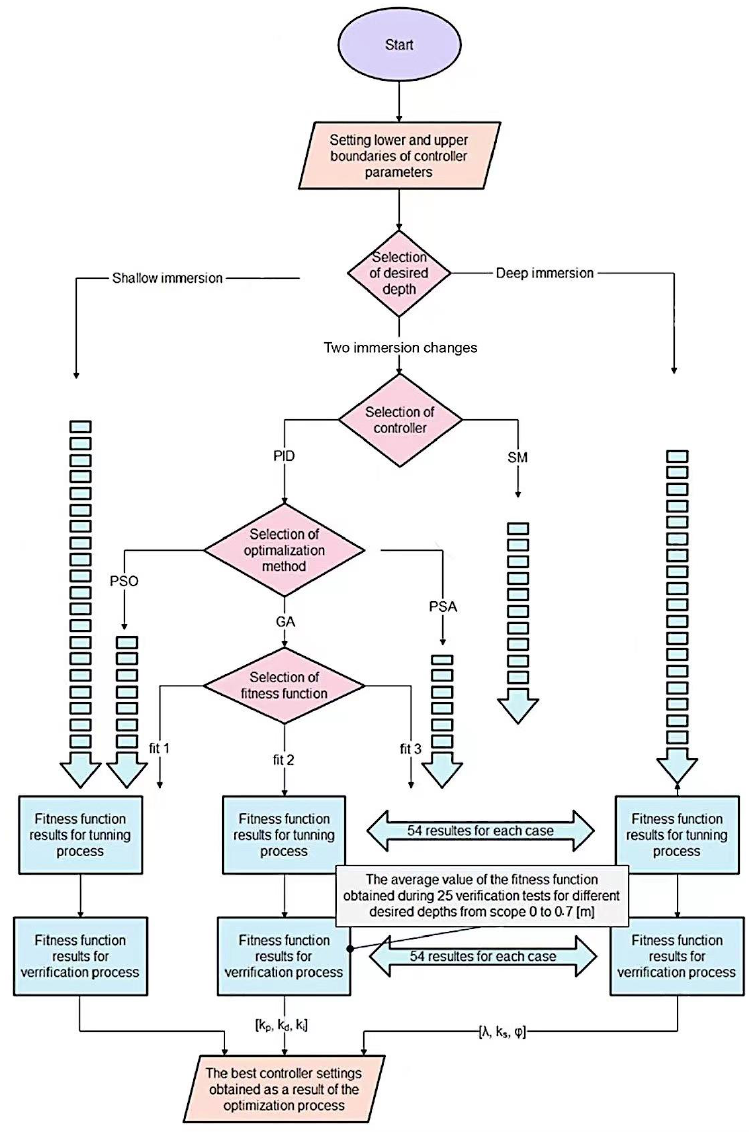
Figure 4. Flowchart optimization process to receive the best controllers